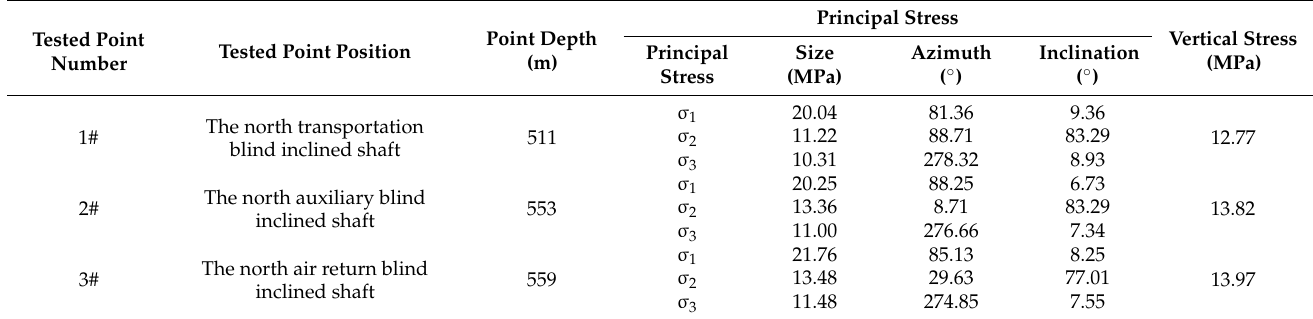
Table 3. In-situ stress test results.